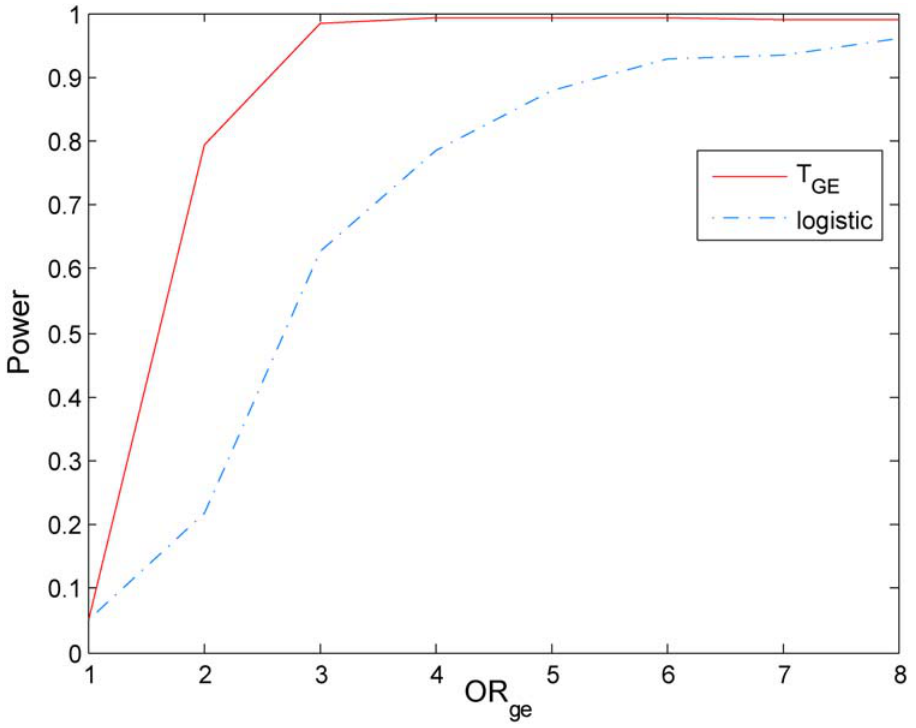
Figure 6. Power of the statistic T I and logistic regression analysis for 400 cases and controls respectively.